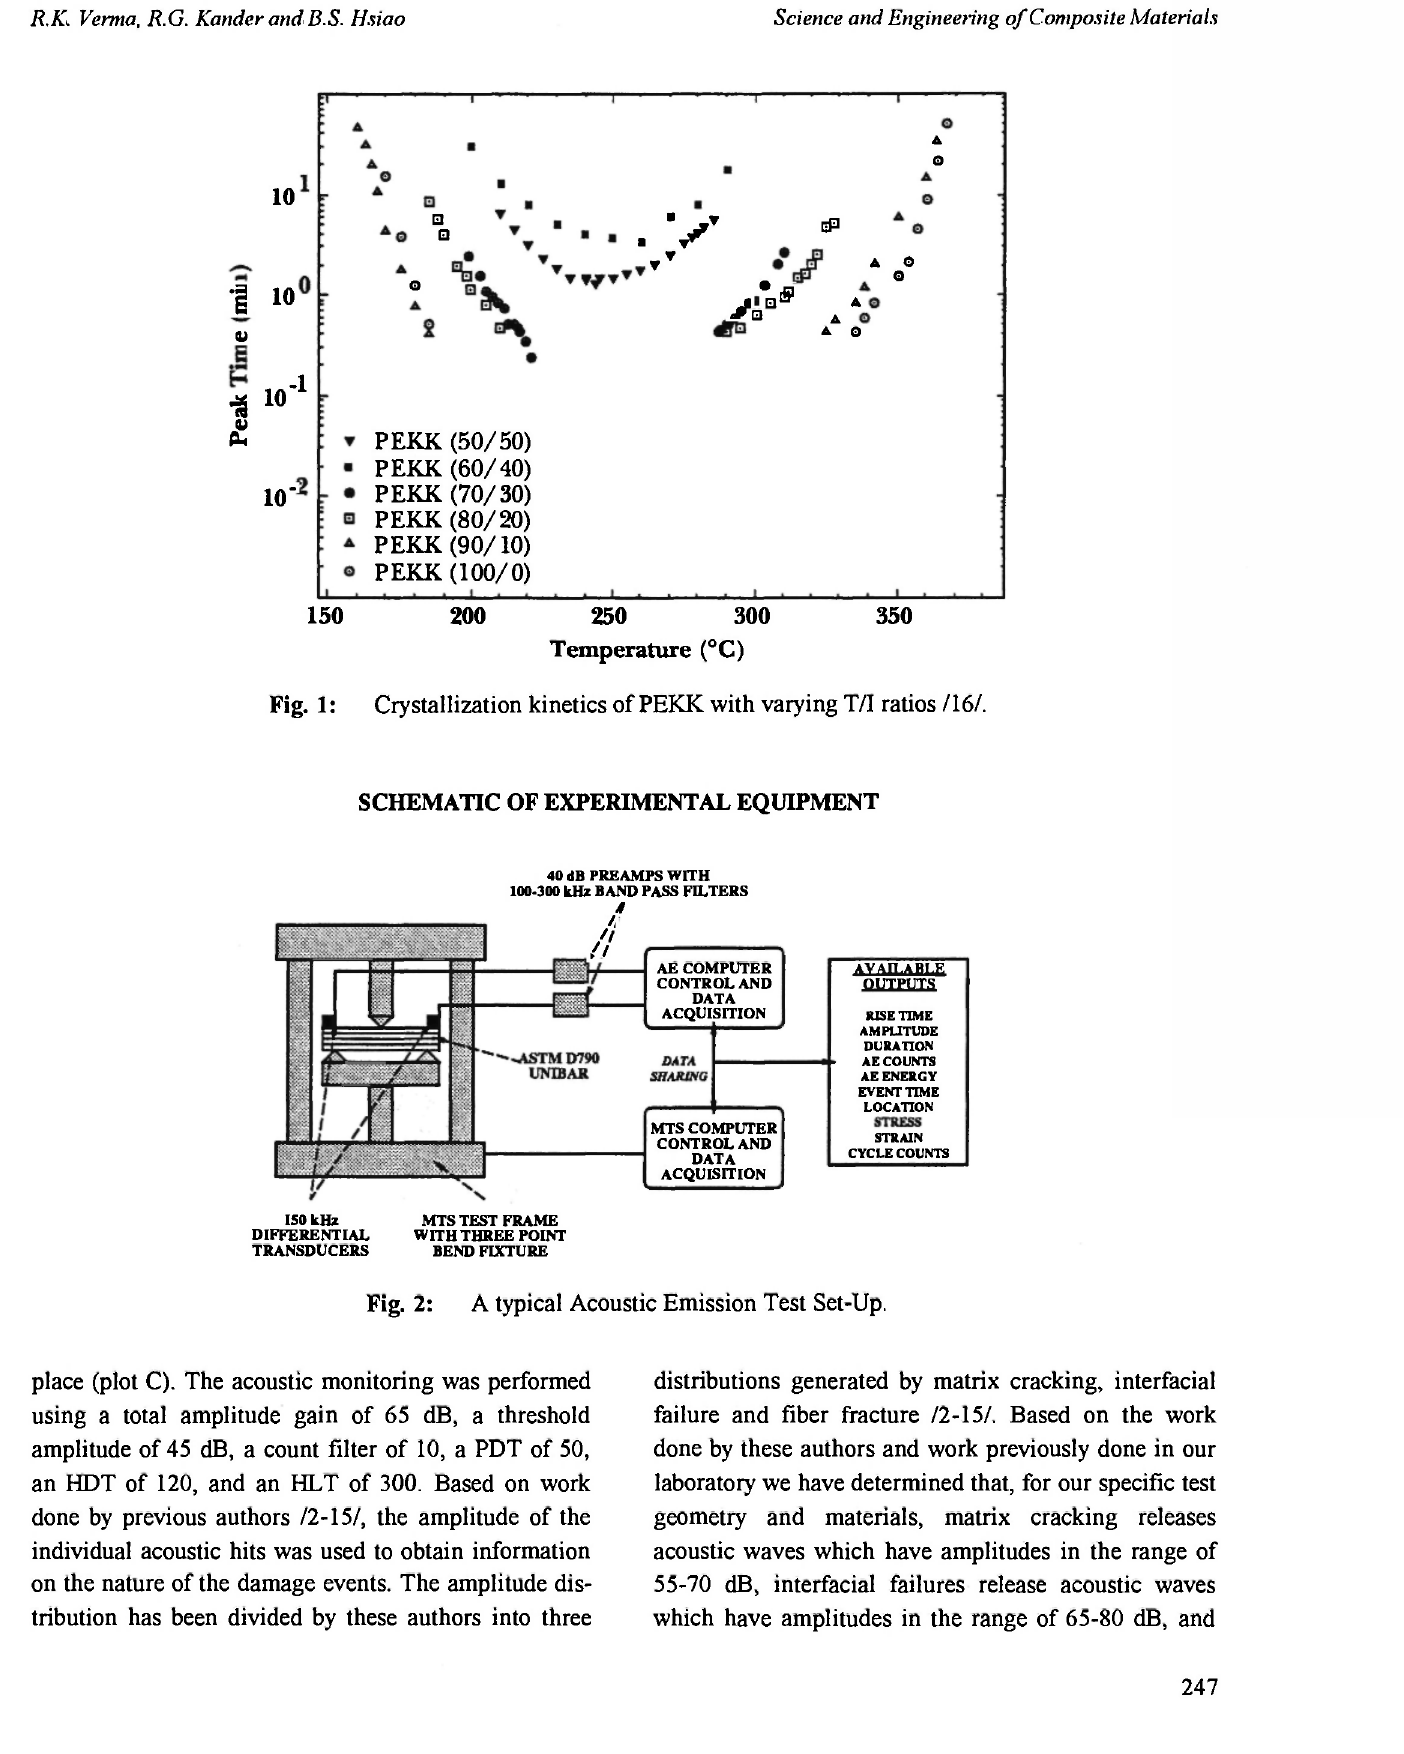
Fig. 1: Crystallization kinetics of ΡΕΚΚ with varying T/I ratios /16/.